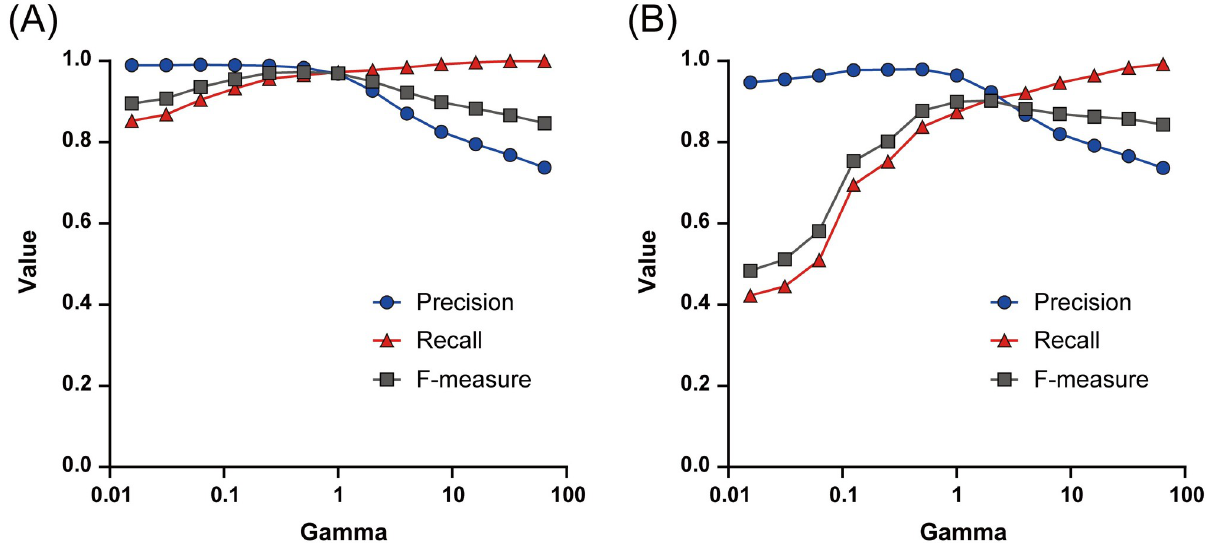
Fig 2. Influence of hyperparameter γ on overall performance of OCSVM models. (A) Analysis for synthetic overdose prescriptions. (B) Analysis for synthetic underdose prescriptions.